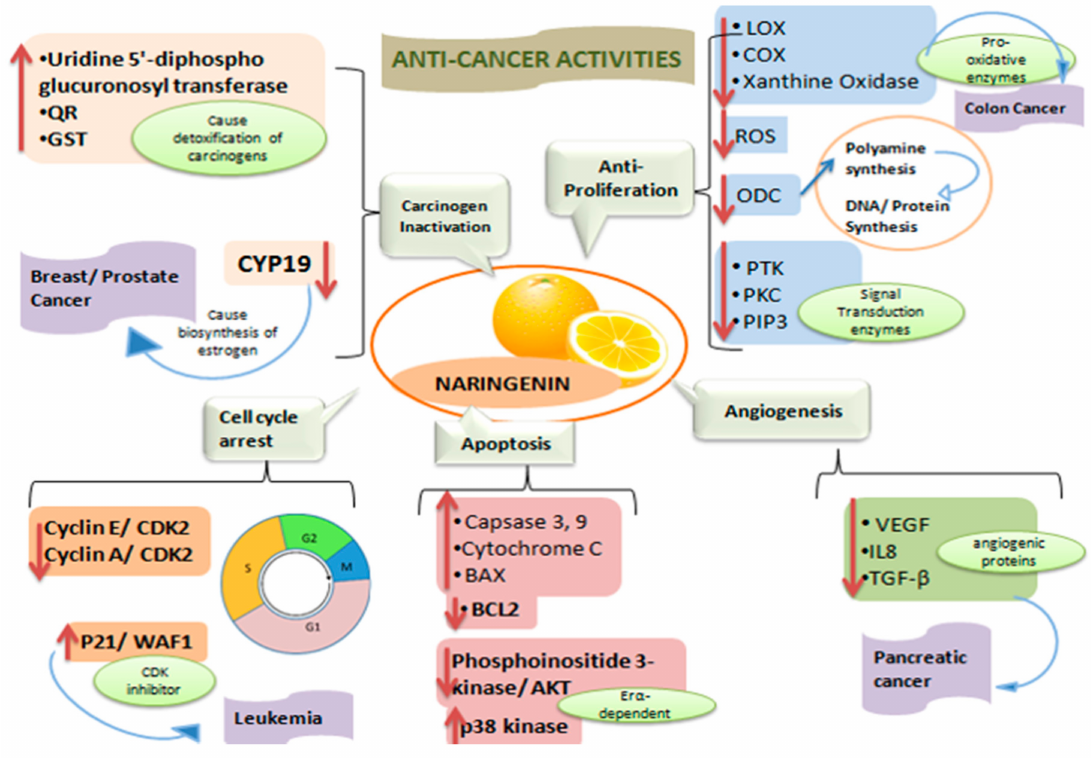
Figure 3. Naringenin found in citrus fruits is a flavonoid that has anti-cancer